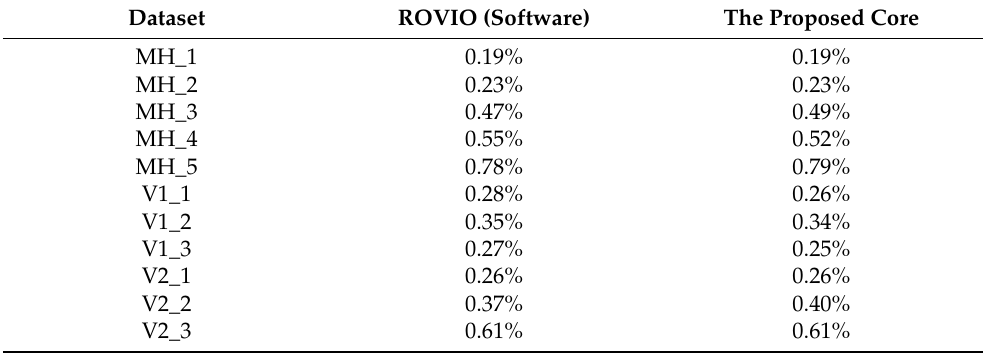
Table 3. Evaluation of